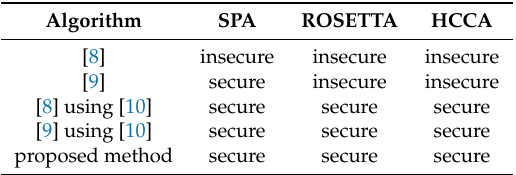
Table 3. The security against side-channel attacks (SCAs) of